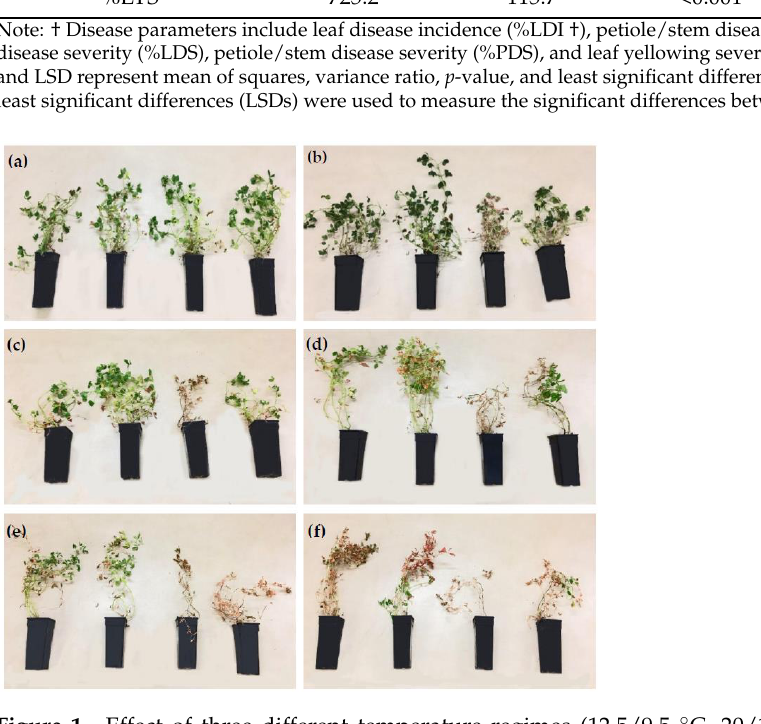
Figure 1. Effect of three different temperature regimes (12.5/9.5 °C, 20/17 °C, and 27/24 °C, day/night) and two different moisture levels (100% and 50% water holding capacity) on Phoma black stem and leaf disease severity in inoculated plants compared to disease-free plants in annual Medicago rugosa cv. Paraponto and M. scutellata cv. Sava. All photos, from left to right, show 50% WHC control plant, 100% WHC control plant, 50% WHC inoculated plant, 100% WHC inoculated plant: ( a ), ( b ), ( c ) = M. rugosa cv. Paraponto under 12.5/9.5 °C, 20/17 °C, and 27/24 °C, respectively; ( d ), ( e ), ( f ) = M. scutellata cv. Sava under 12.5/9.5 °C, 20/17 °C, and 27/24 °C, respectively.